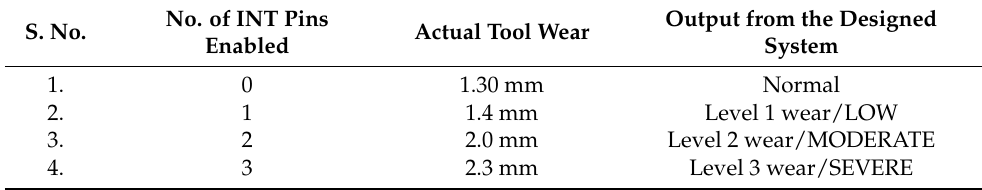
Table 8. Experiment results of the tool wear-out detection system. S.